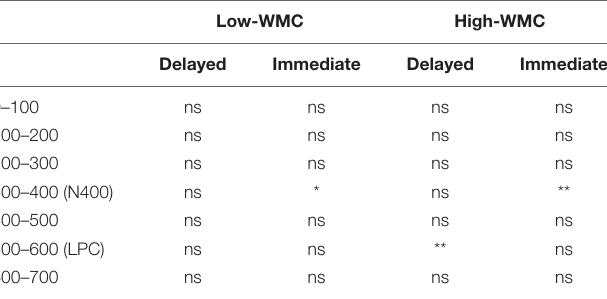
TABLE 3 | Time-course analyses of the ERP priming (unrelated minus related) effects for consecutive 100 ms time windows, as a function of WM capacity and masking